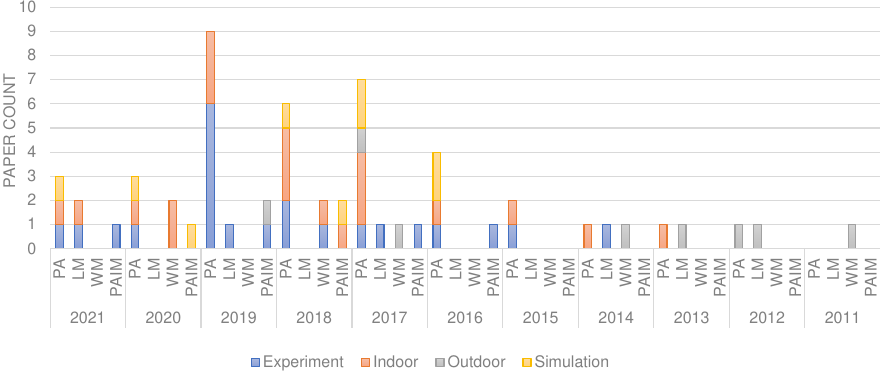
Figure 10. IoT and WSN domains and deployment environment in smallholder agriculture researches (PA:Precision Agriculture, LM: Livestock Management, WM: Weather Monitoring, PAIM: Pest and Animal Infestation Monitoring). The Y-axis labels denote works under each deployment environment and application